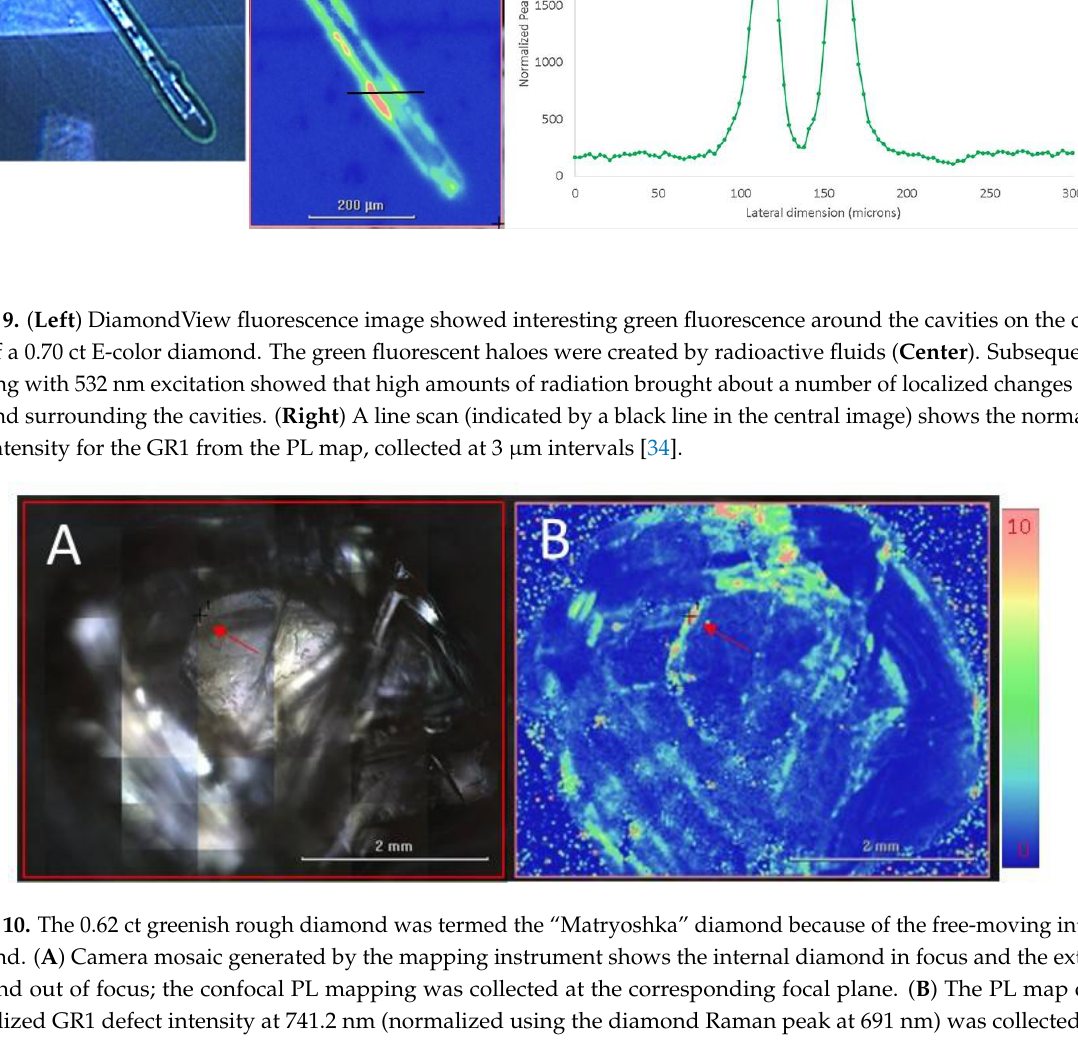
Figure 9. ( Left ) DiamondView fluorescence image showed interesting green fluorescence around the cavities on the crown facet of a 0.70 ct E-color diamond. The green fluorescent haloes were created by radioactive fluids ( Center ). Subsequent PL mapping with 532 nm excitation showed that high amounts of radiation brought about a number of localized changes in the diamond surrounding the cavities. ( Right ) A line scan (indicated by a black line in the central image) shows the normalized peak intensity for the GR1 from the PL map, collected at 3 µm intervals [34].